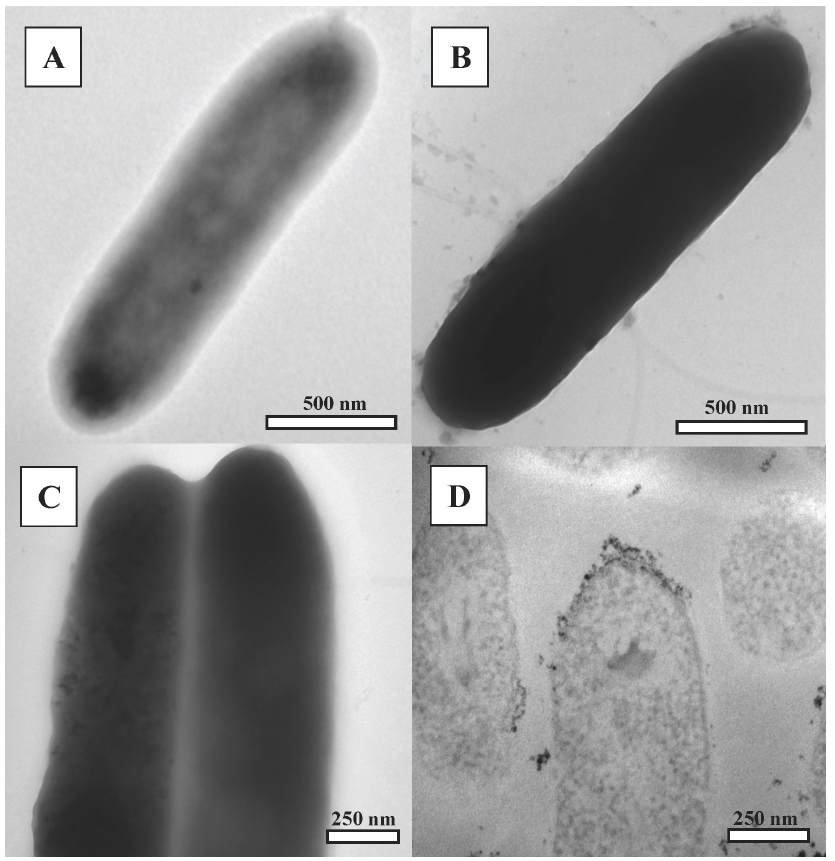
Figure 3. Whole mount TEM micrographs of C. metallidurans exposed to 5000 µM Pt(II) for: ( A ) 1 min, binding of Pt is minimal as cell remains generally electron transparent; ( B ) 1 h; and ( C ) 1 day. At longer incubation times ( B , C ), cell staining is apparent in all cells; ( D ) Ultra-thin section TEM micrograph of C. metallidurans exposed to 5000 µM Pt(II) for 1 h. Nanoparticle Pt is immobilized along the cell envelope, in particular at some cell poles, and in the cytoplasm.